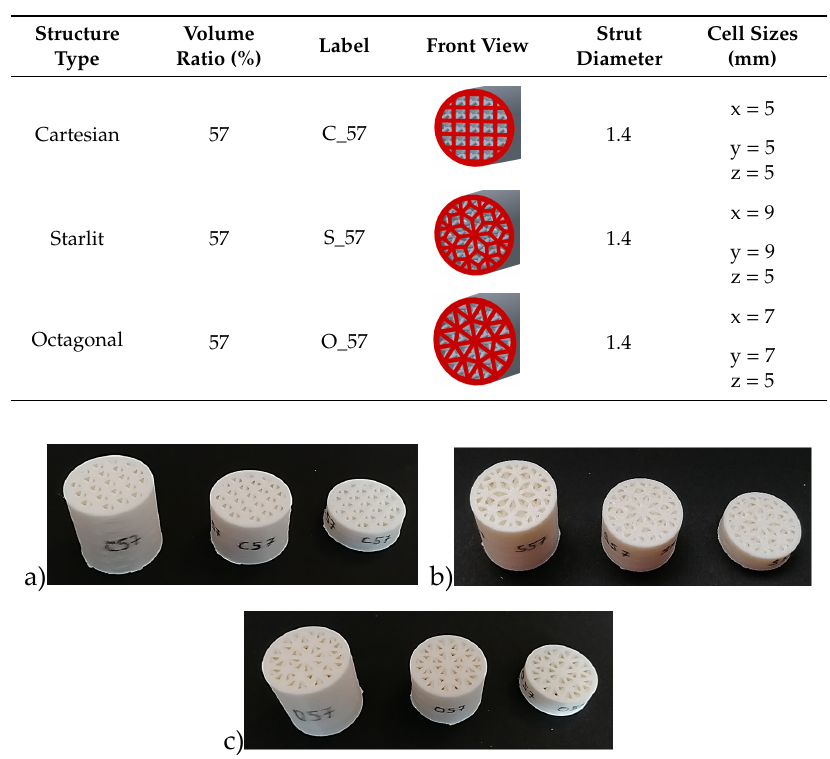
Table 1. Types of 3D-printed structures.